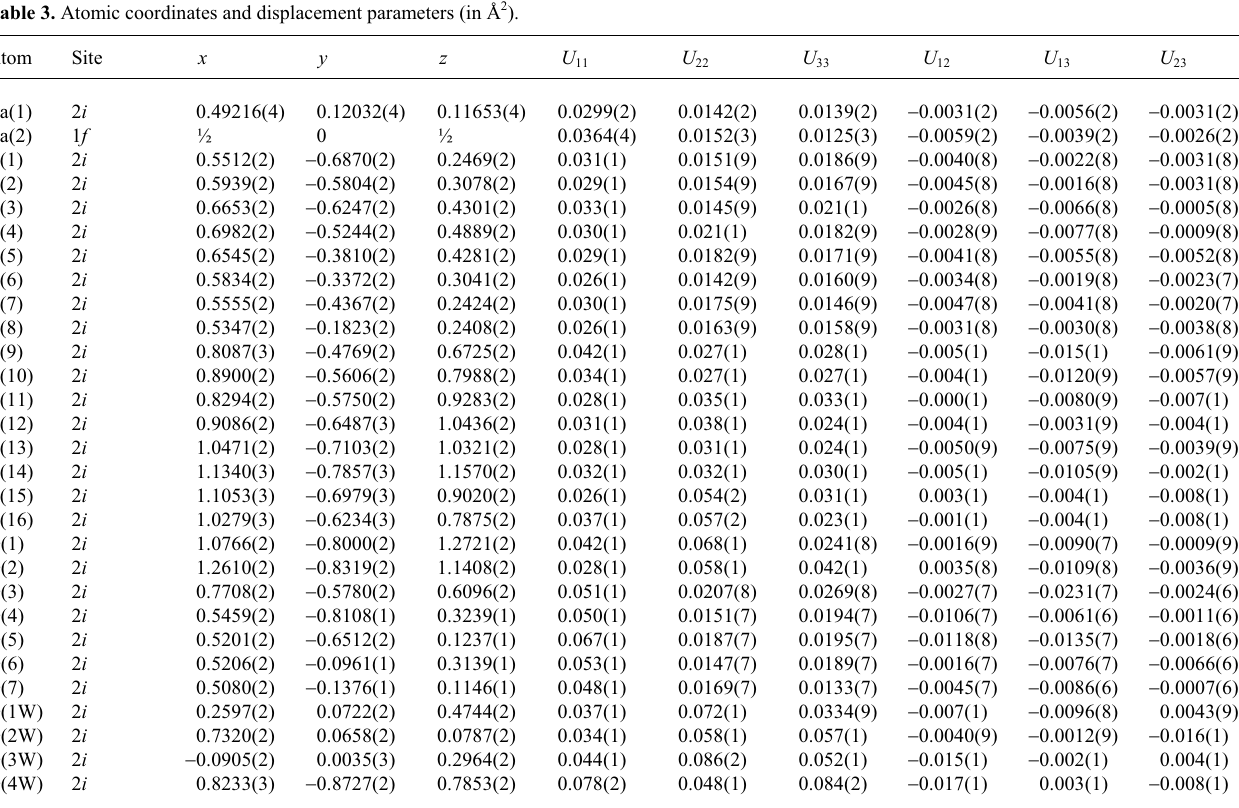
Table 3. Atomic coordinates and displacement parameters (in Å 2 ).